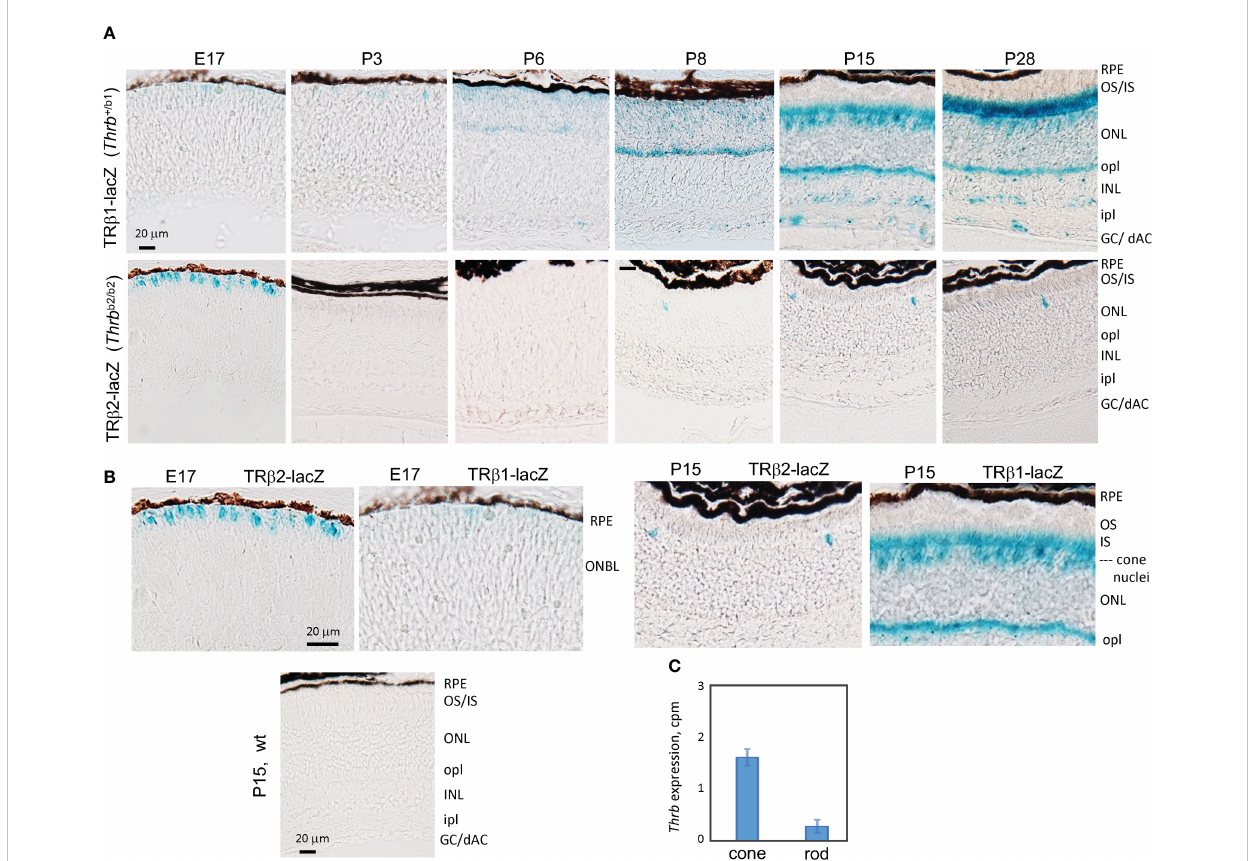
FIGURE 3 Developmental expression of TR b 1 in the retina detected in Thrb b1 lacZ reporter mice. (A) , TR b 1 detected as b -galactosidase activity using x-gal substrate (blue) in cryosections from Thrb +/ b1 reporter mice. TR b 2 was detected using Thrb b2/b2 lacZ mice. X-gal color reaction times were overnight (~16 hr) except at P28 for Thrb +/b1 , with a time of 6 hr to avoid saturation of signal. At least 6 retinas (n ≥ 3 mice) analyzed per stage. (B) , Higher magni fi cation showing the shift from TR b 2 to TR b 1 expression in cone differentiation. Wild type (wt) sections gave little or no background. (C) , RNA- seq detection of Thrb (total gene) expression in isolated cones and rods; mean ± S.D., 34 cones, 29 rods; 2 month old mice. GC/dAC, ganglion cell/ displaced amacrine cell layer; INL, inner nuclear layer; ipl, inner plexiform layer; IS, inner segments; ONBL, outer neuroblastic layer; ONL, outer nuclear layer; opl, outer plexiform layer; OS, outer segments, RPE, retinal pigmented